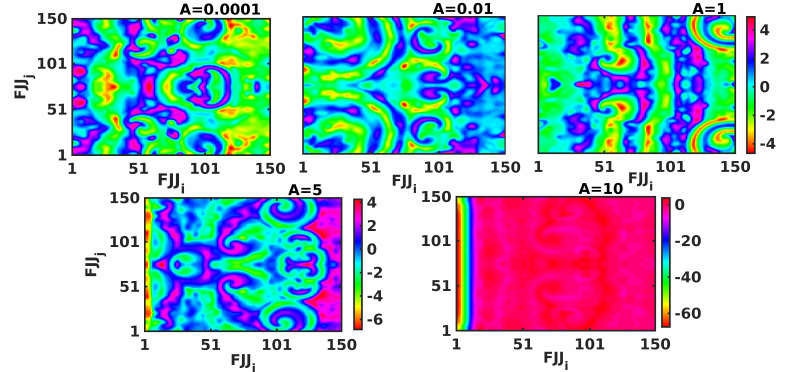
Figure 6. The energy of each node in a lattice network of FJJ by fixing different values of the amplitude of external stimulus (A). Other parameter values are fixed as D = 1.0, q = 0.98, d = 0.31, and δ = 0.0.